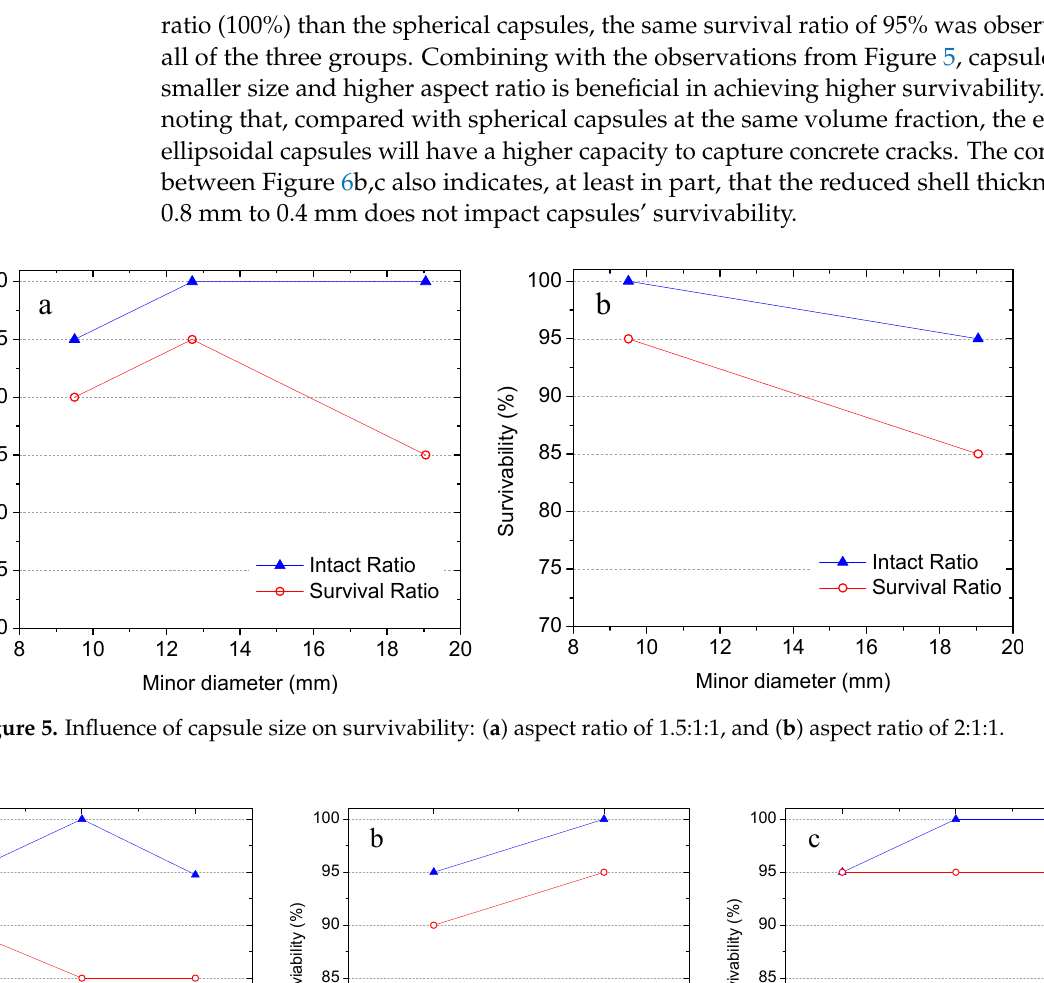
Figure 5. Influence of capsule size on survivability: ( a ) aspect ratio of 1.5:1:1, and ( b ) aspect ratio of 2:1:1.